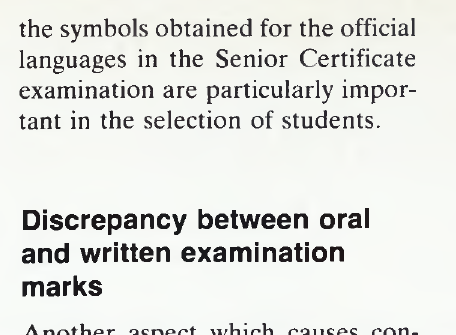
Figure 3 Diploma in General Nursing Anat­ omy — June 1985 First Entries n = 883